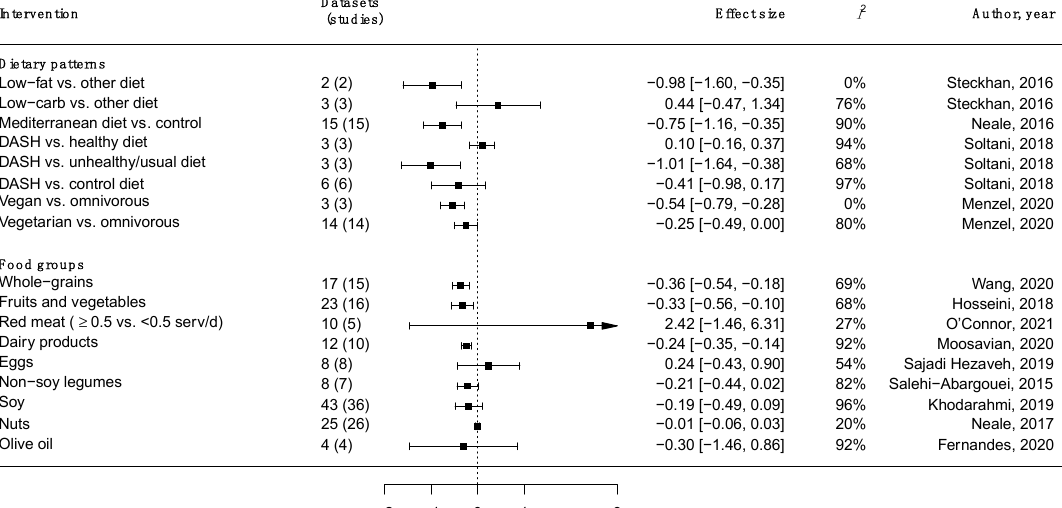
dietLow−fat controlLow−carb vs. other dietMediterranean diet vs. dietDASH vs. healthy dietDASH vs. unhealthy/usual